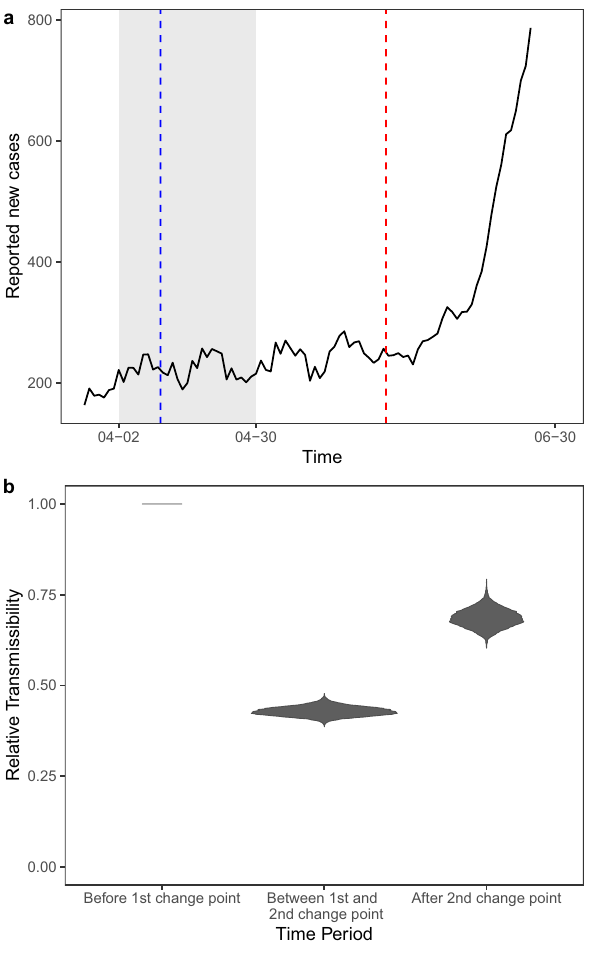
Figure 1. ( a ) Change points. The grey area represents period with active shelter-in-place order. The blue line indicates the model-inferred (free) change point time at which there was a major reduction of population-level transmissibility. The red line indicates the change point at which there was a major uptick of transmissibility. Note that the reduction of transmissibility at first change point also appears to have largely leveled off the overall increasing trend of cases (illustrated by the black curve showing the 7-day moving average) before the next major uptick. ( b ) Transmissibility compared to the transmissibility in the period before the first change point (blue line). It on average reduced to 41.2% [39%, 43.8%] during the period between the first and second change points, and restored to 62% [58%, 67.2%] after the second change